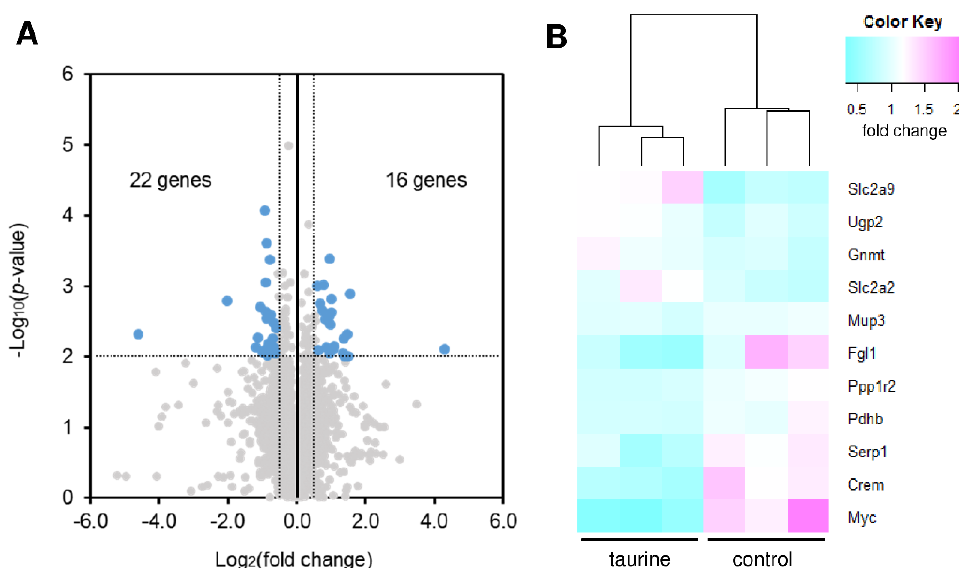
Figure 5. Microarray analysis in the liver from taurine-treated mice. ( A ) Volcano plots showing the differential expression patterns between taurine-treated and control groups. ( B ) Heat maps showing the differentially expressed genes ( p < 0.05) annotated with GO term for glycogen biosynthesis (GO: 0005978), glucose metabolic process (GO: 0006006), UDP-glucose metabolic process (GO: 0006011) and glucose transport (GO: 0046323) in the liver between taurine-treated and control mice.